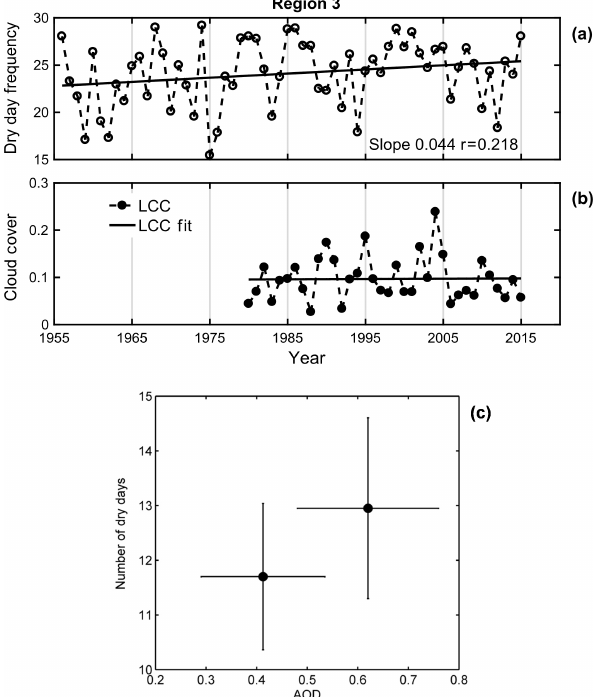
Figure 8. Statistical comparison of the climatology of all parame- ters during July for region 3 during various time spans. (a) Dry day frequency values between 1956 and 2015 and (b) low cloud cover during 1980–2015. (c) Sequential association between aerosol growth (16–30 June) and DDF (1–15 July).